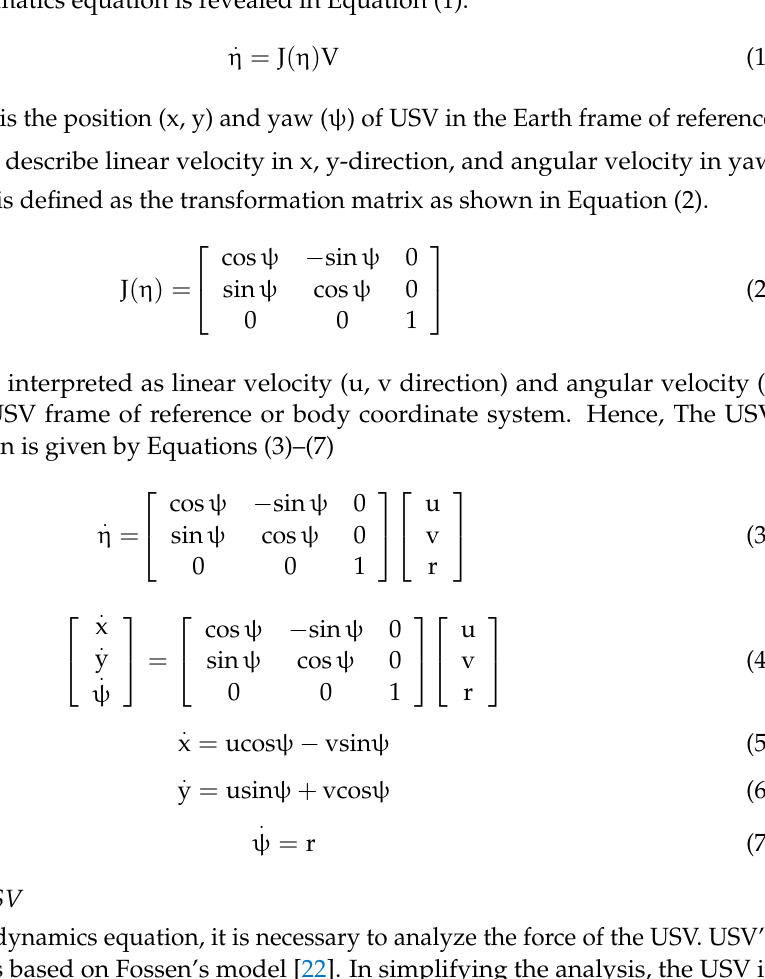
Table 1. Standard notation of USV motion. Forces and Linear and Angular Position and DOF Motions Moments Velocities Euler Angle 1 Surge X u x 2 Sway Y v y 3 Yaw N r